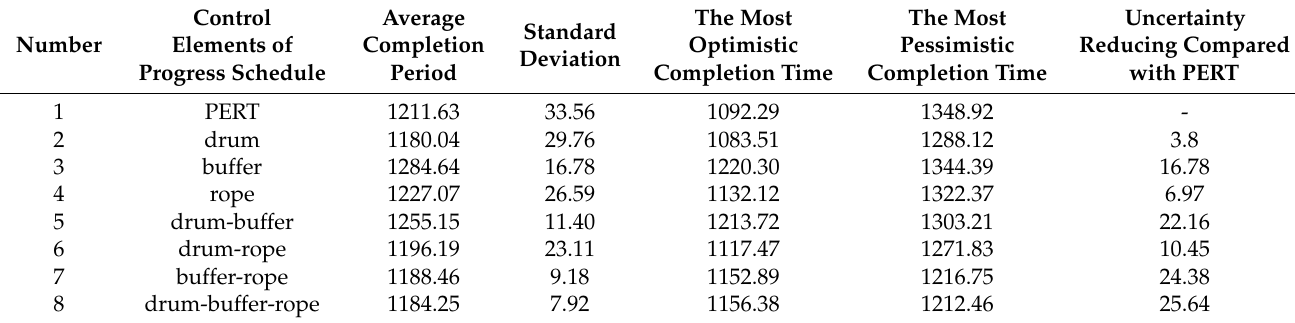
Figure 4. Simulation results under different combinations. Table 2. Comparison table of simulation uncertainty of various